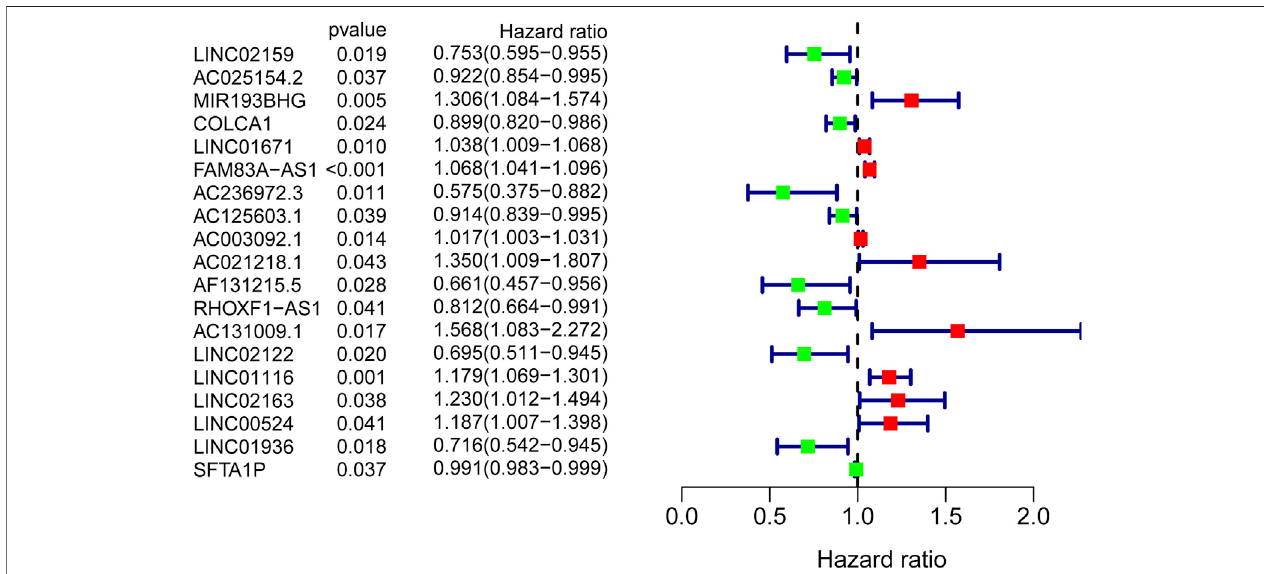
FIGURE 3 | GI-lncRNAs associated with the prognosis of LUAC patients in the univariate Cox regression analysis. A total of 19 GI-lncRNAs were signi fi cantly associated with OS, including 9 risk factors for OS and 10 protective factors.